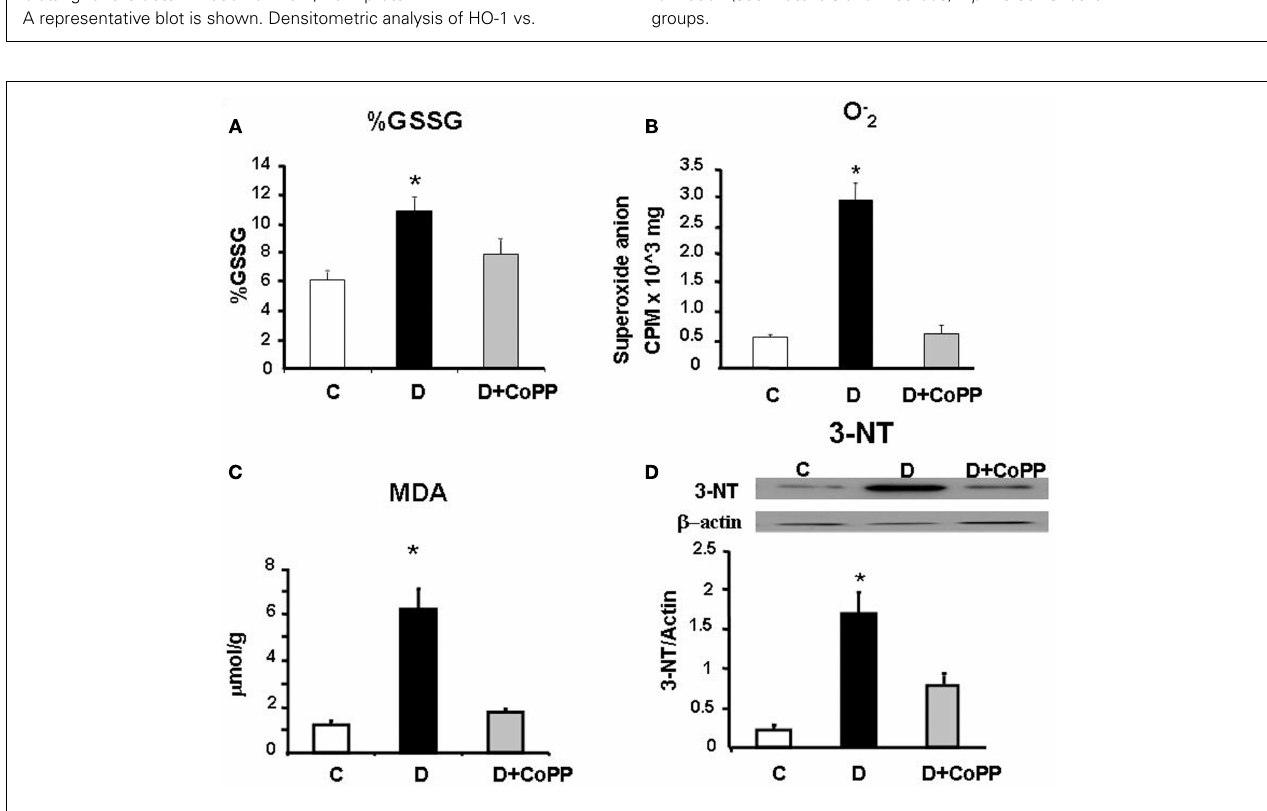
actin is shown and expressed as means ± SEM of three independent experiments. HO activity was determined by bilirubin formation (see Materials and Methods). * p < 0.05 vs. other groups.